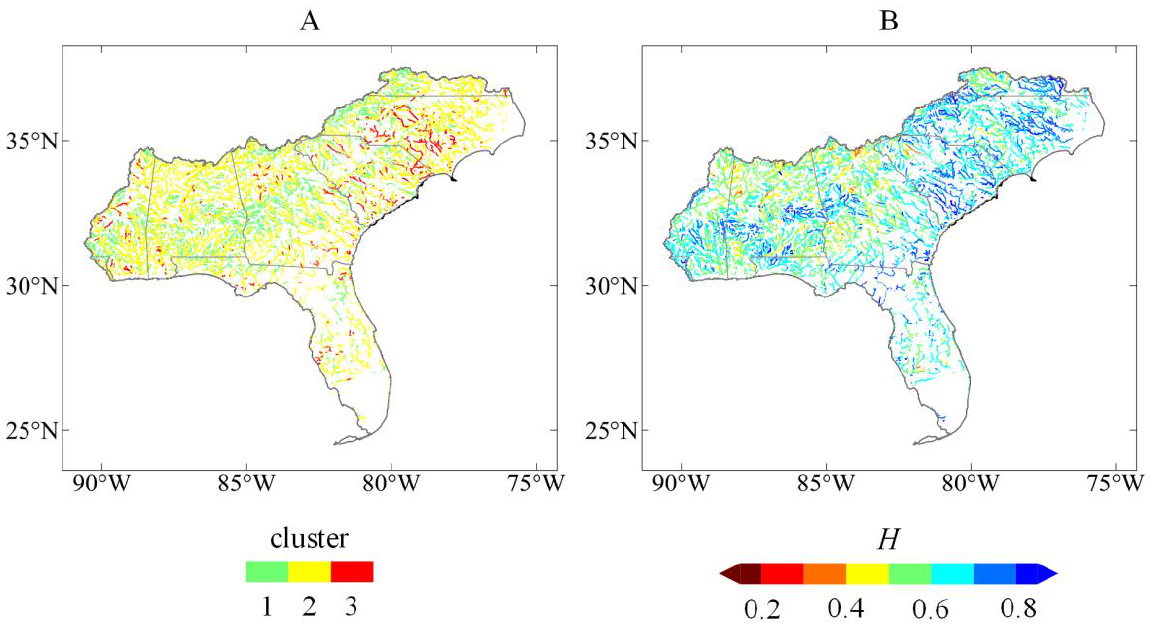
Figure 3. Annual low flow occurrence spatial clusters ( A ) and Hurst exponent values ( B ) in studied nodes.